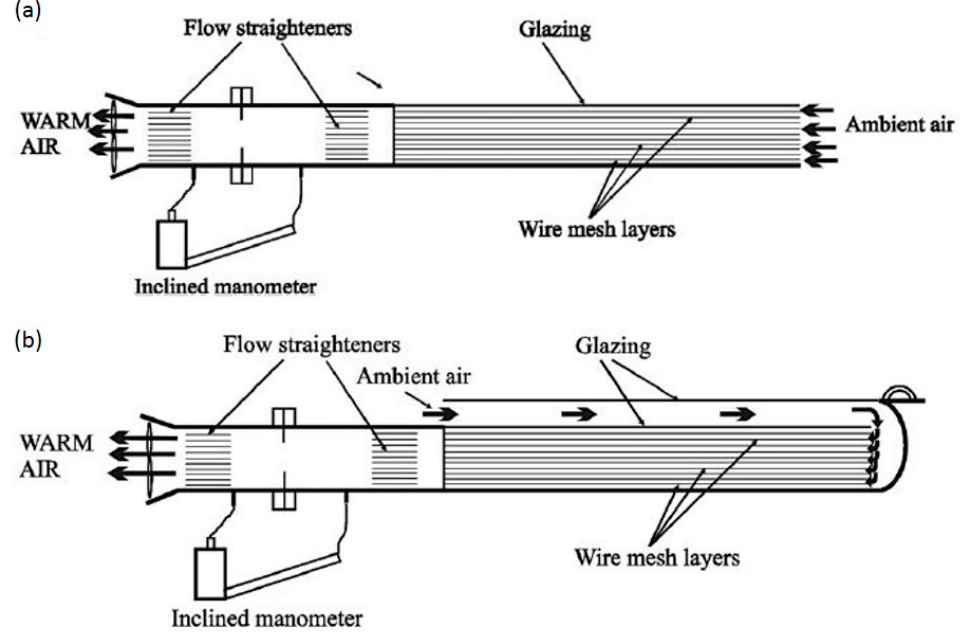
Figure 1. Schematic diagram of ( a ) a single-pass and ( b ) double-pass solar air heater with a packed bed [13].